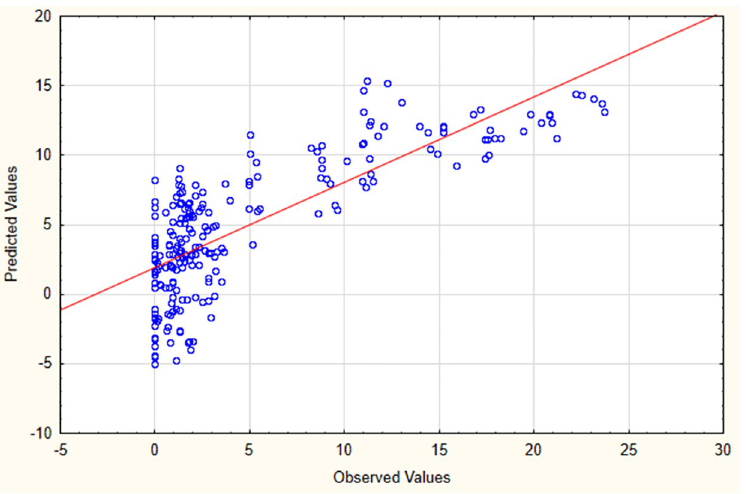
Fig 7. Observed vs. predicted values of larval density according to Generalized Linear Model (GLM) (Multiple R 2 value 0.61).